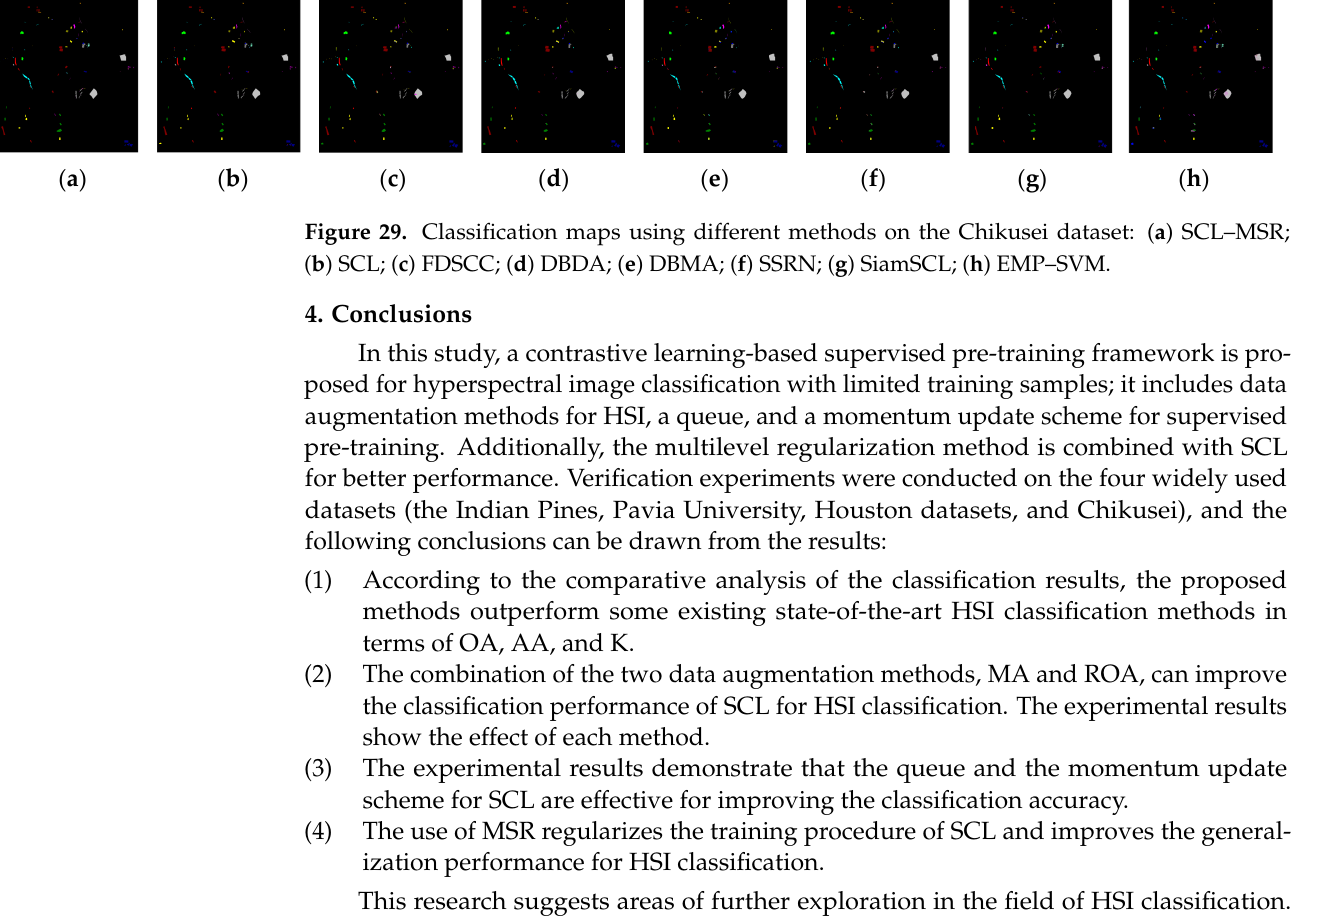
Figure 28. Classification maps using different methods on the Houston dataset: ( a ) SCL – MSR; ( b )